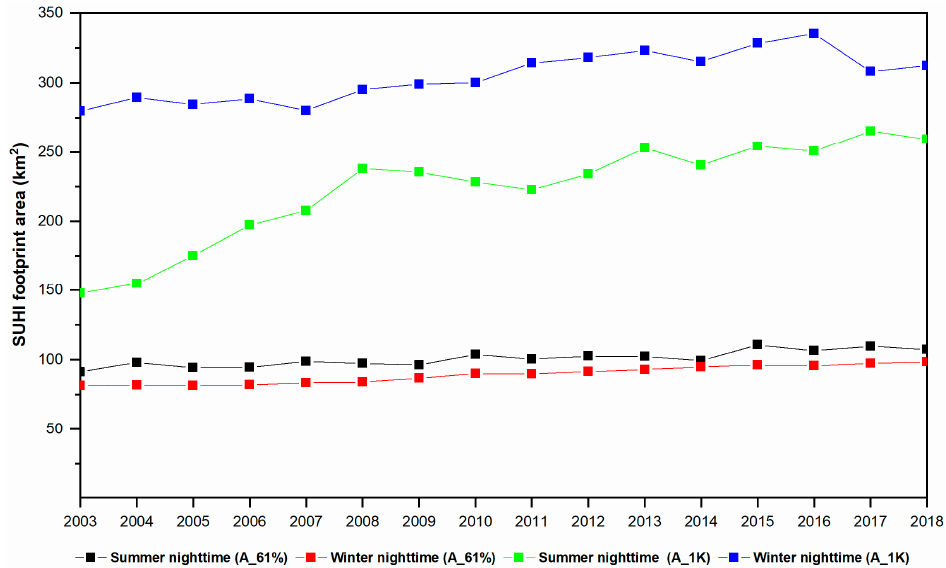
Figure 6. Temporal variation of the nighttime SUHI footprint A_61% and A_1K (km 2 ) from 2003 to 2018 during the summer and winter season.